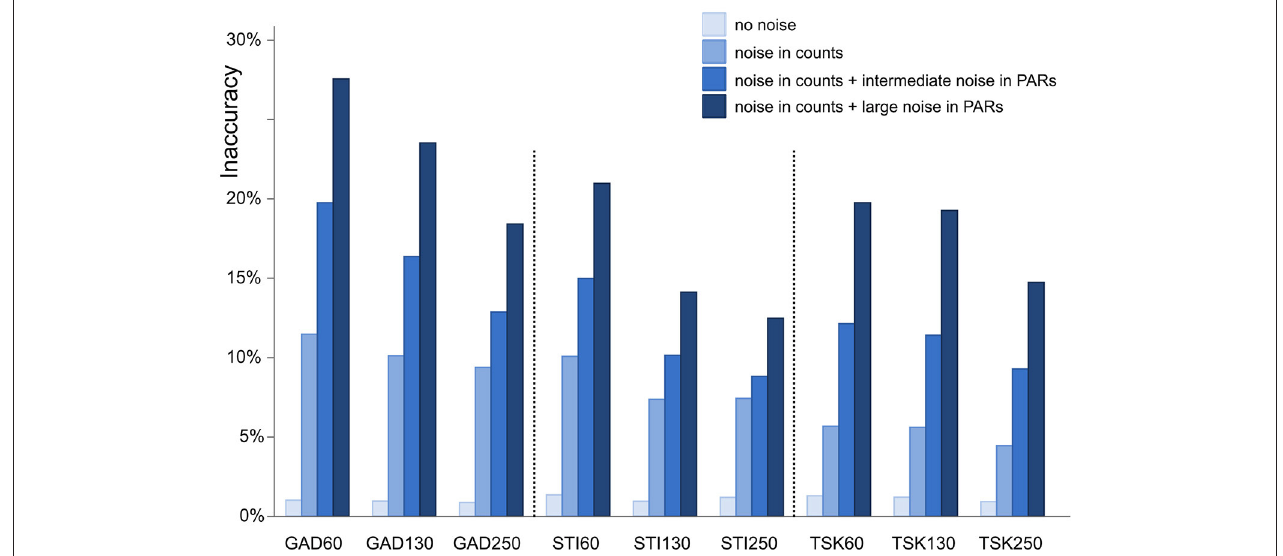
FIGURE 3 | Inaccuracy of ROPES reconstructed landcover expressed as mean proportion of the landscape for which the reconstruction is wrong. Accuracy is assessed for 9 synthetic data sets representing 3 sites (GAD, STI, and TSK) each with 3 sizes (60, 130, and 250 samples). Four different types of error are applied (no error, error in pollen counts, error in counts plus intermediate noise in PAR values, and error in counts plus large noise in PAR values).